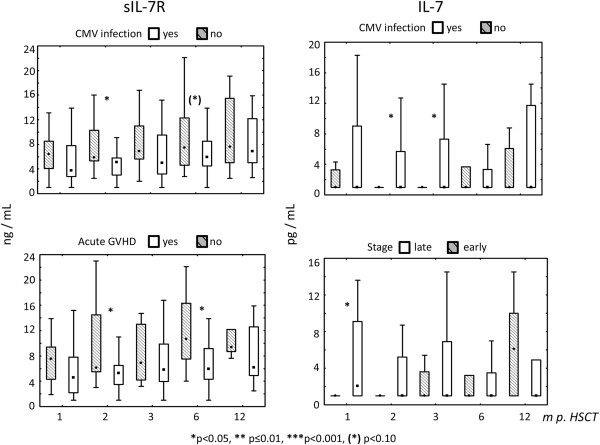
Levels of sIL-7R and IL-7 after HSCT, cytomegalovirus (CMV) reactivation (CMV PCR positivity) versus no CMV infection/reactivation, acute graft-versus-host disease (GVHD) grades I–IV versus no GVHD and stage of disease: early versus late.